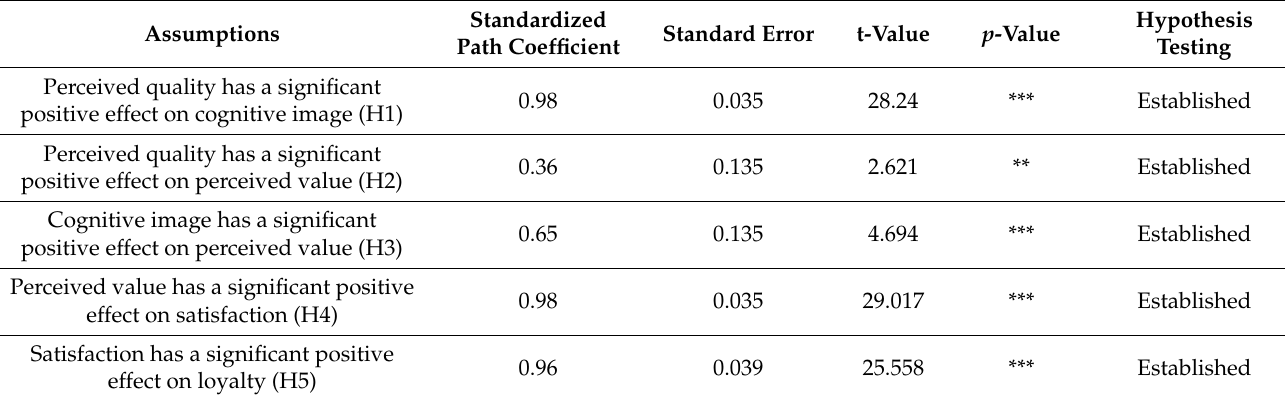
Table 9. Results of path hypothesis